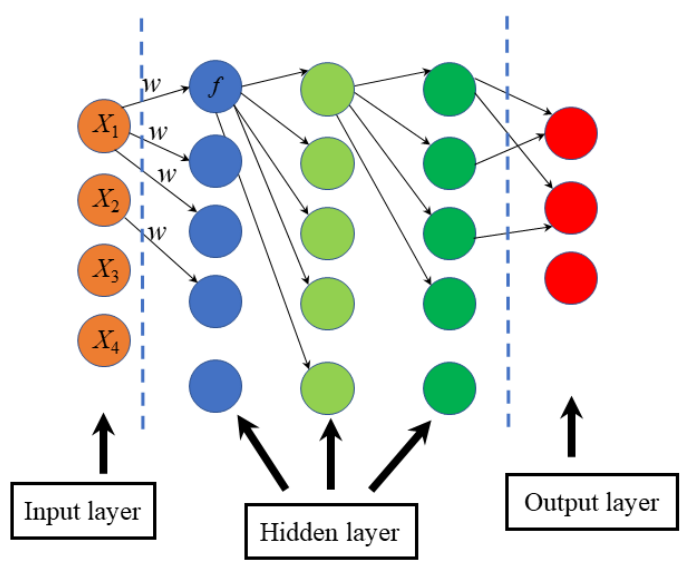
Figure 7. Deep BP neural network structure.